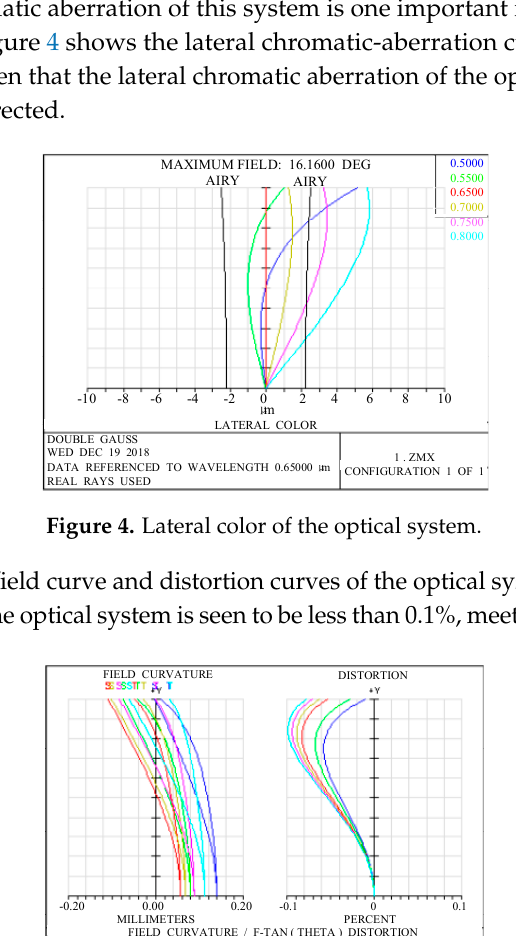
Figure 7. Nighttime light remote-sensing image. This camera has high resolution and good imaging quality, and can clearly see roads and blocks, thereby meeting the application requirements of nighttime light remote sensing.